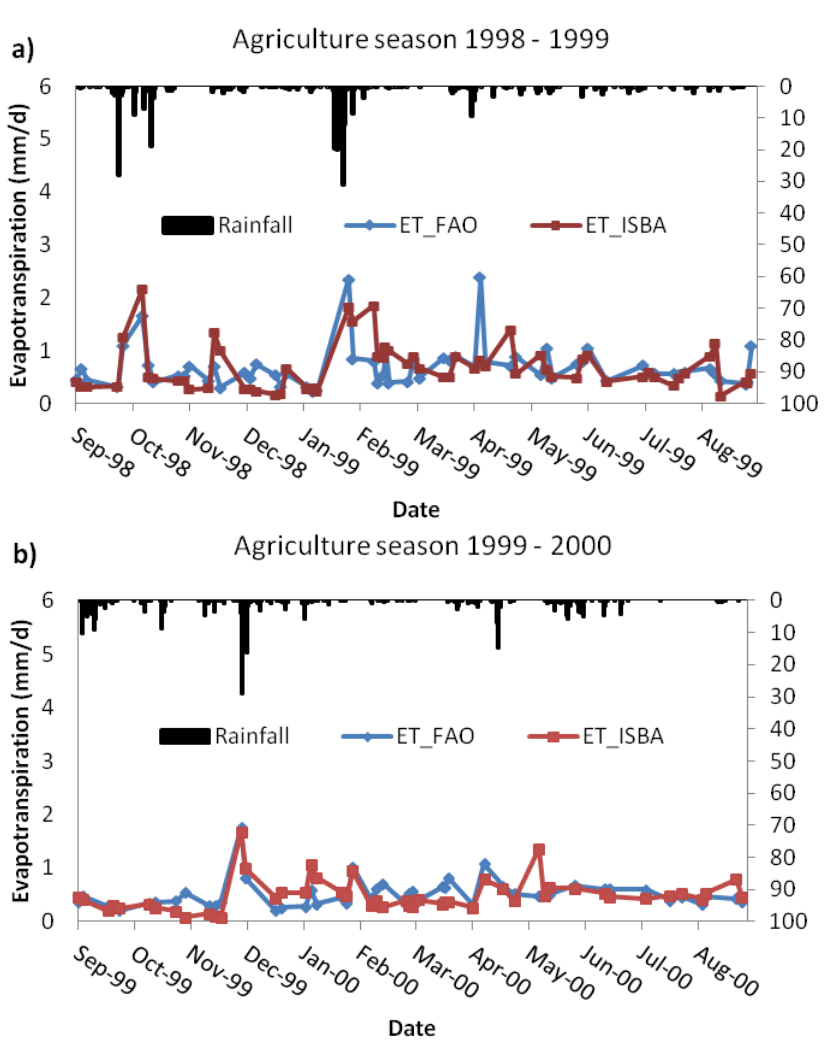
Figure 5. Inter-comparison between ET outputs from the FAO-56 and ISBA-A-gs models, on dates when remotely sensed ERS/WSC observations were recorded: ( a ) 1998–1999 agricultural season; ( b ) 1999–2000 agricultural